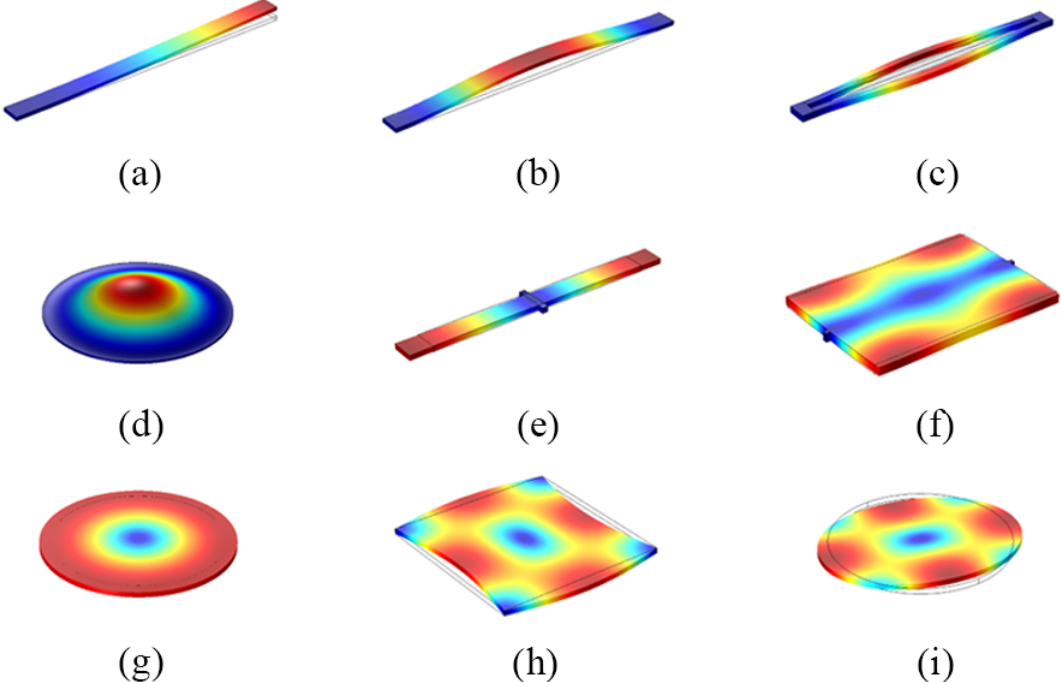
Figure 2. Diagrams of flexural modes ( a – d ) and bulk modes ( e )-( i ): ( a ) Single-ended fixed out-of- plane mode; ( b ) Double-ended fixed out-of-plane mode; ( c ) Double ended tuning forks (DETF) in- plane mode; ( d ) Above-membrane out-of-plane mode; ( e ) Length extension (LE) mode; ( f ) Width expansion (WE) mode; ( g ) Radial breathing mode; ( h ) Lamé mode; ( i ) Wine-glass mode, or face- shear (FS) mode when the resonator is rectangular.